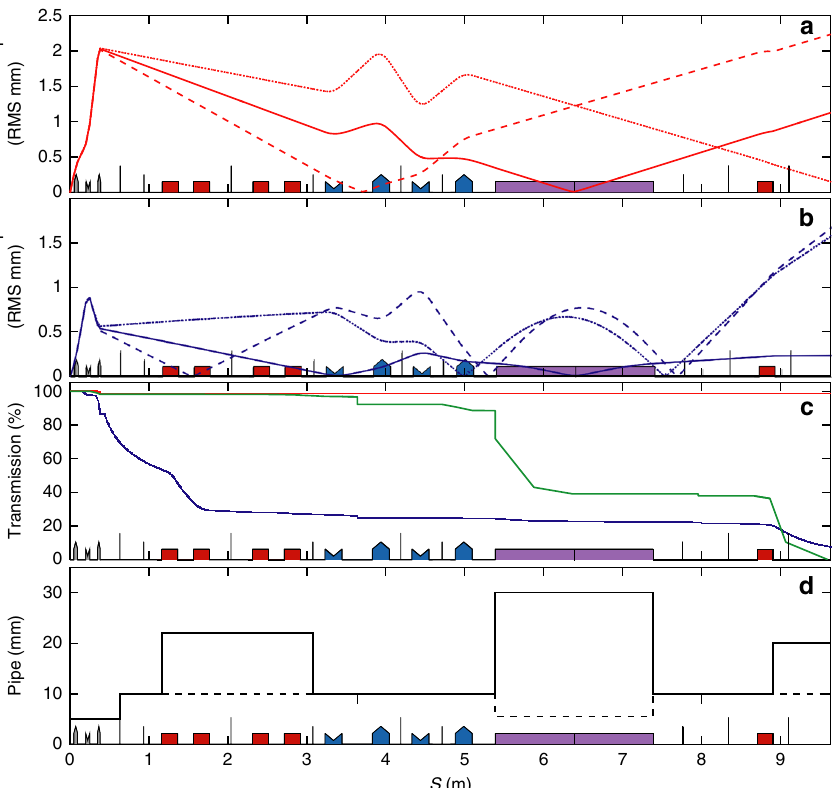
Fig. 4 Electron beam properties along the line. a Horizontal and b vertical envelopes for 171 (dashed), 176 (solid) and 181 (dotted) MeV electron beam energies. c Losses along the line: 176 (red), 150 (green) MeV, spectrum from Fig. 2 (blue). d Horizontal (vertical) pipe diameter: dashed (solid). QUAPEVAs (grey), dipole (red), electromagnetic quadrupoles (blue), undulator (purple)